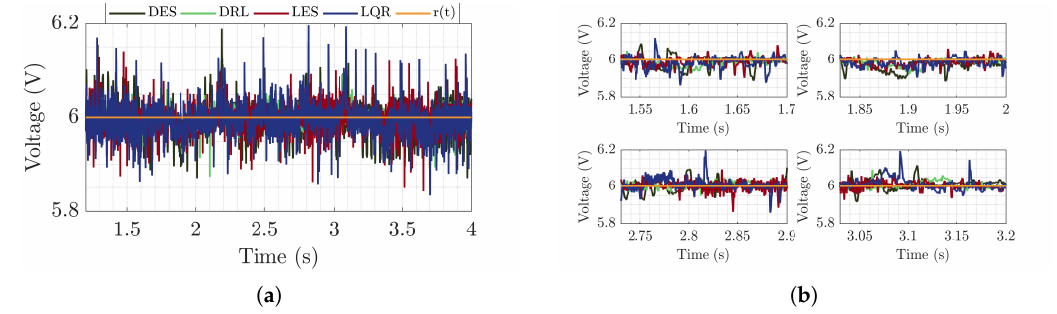
Figure 27. ( a ) Regulated voltage delivered to the DC bus. ( b ) Zoom to the oscillations caused by the power variation of the CPL boost during the